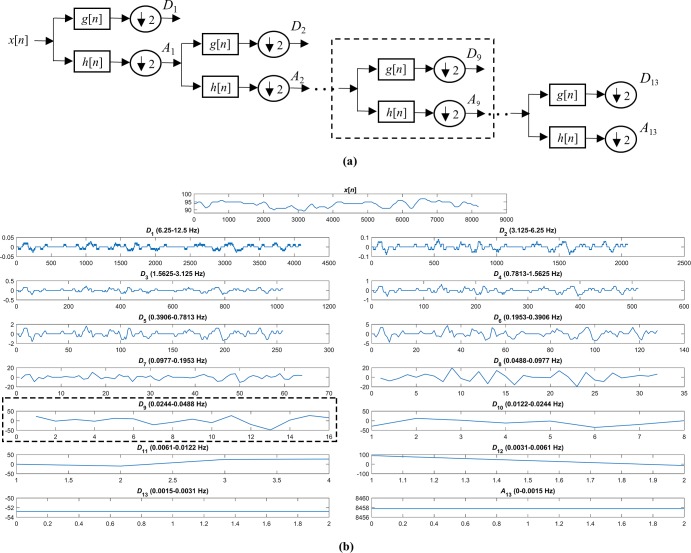
DWT computation.(A) Decomposition process of a signal using DWT. (B) Original SpO2 signal, detail signals at each decomposition level and approximation signal at the maximum level of the decomposition.